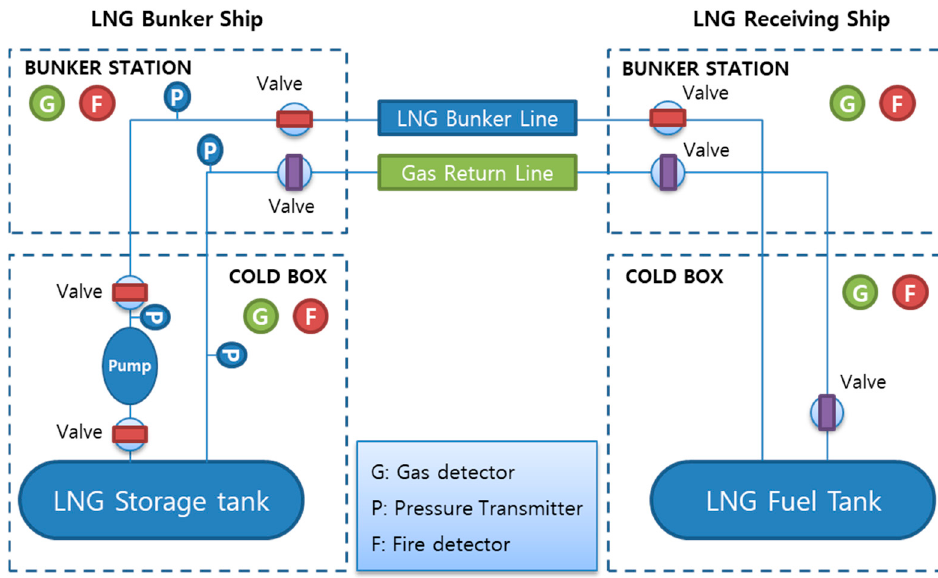
Figure 3. Simplified process flow diagram of the ship-to-ship LNG bunkering [12].